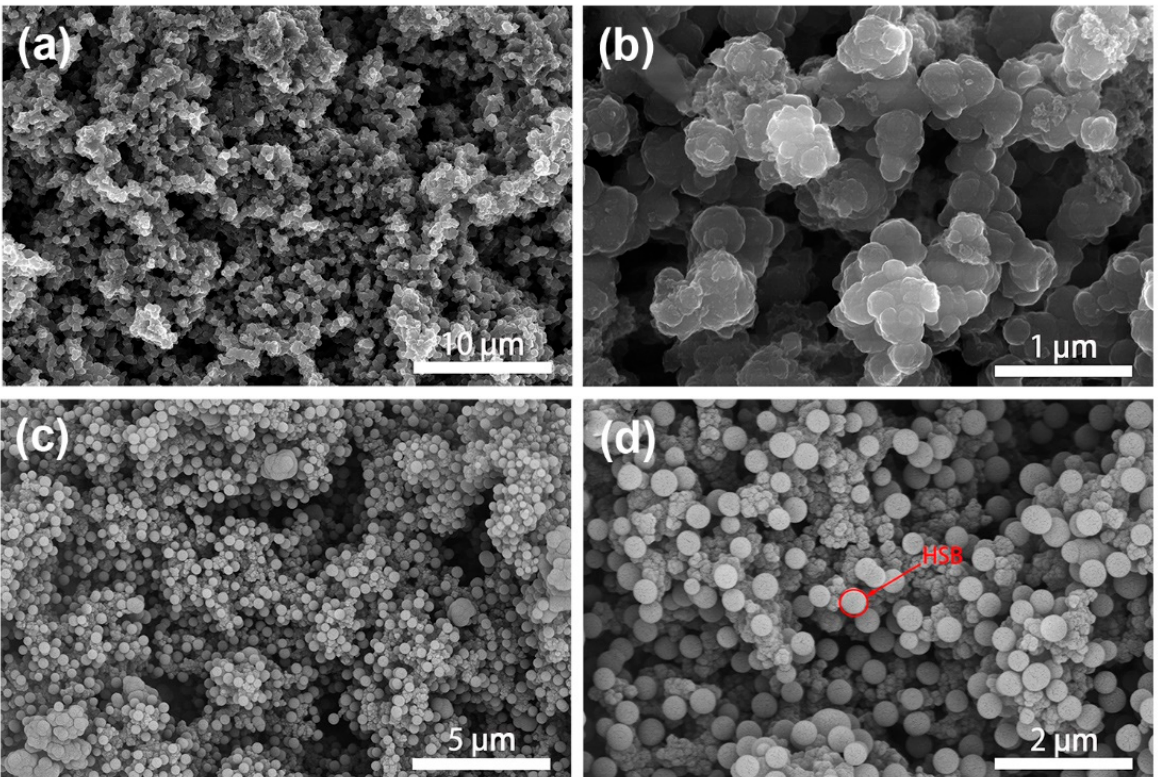
Figure 4. SEM of pure PPy ( a ), HSB-0.6 ( b ) and PPy/HSB-0.6 ( c , d ).